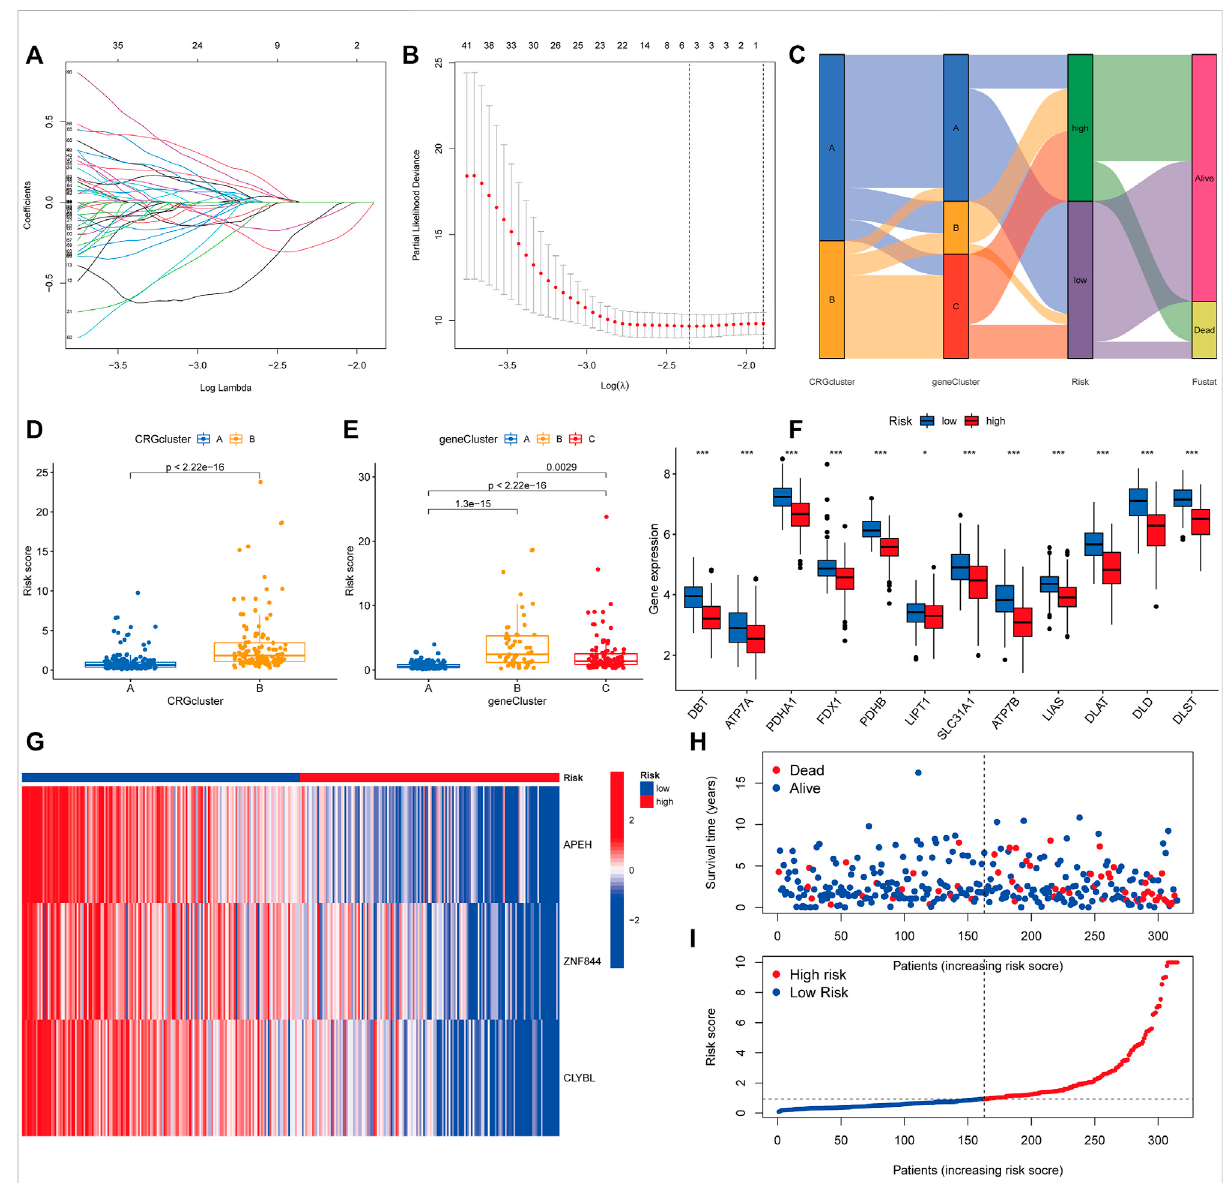
FIGURE 6 Developing the prognostic risk score. (A,B) Least absolute shrinkage and selection operator (LASSO) regression and partial likelihood deviance on prognostic genes. (C) Distributions of various CRG clusters, gene clusters, risk scores, and survival outcomes are shown in alluvial plots. (D) Differences in risk scores between two CRG clusters. The Wilcoxon rank-sum test revealed that the differences between the two clusters were statisticallysigni fi cant( p < 0.001). (E) Differencesinriskscoresamongthreegeneclusters.TheKruskal-Wallistest( p < 0.001)wasusedtoassess the differences between the three gene clusters. (F) Histogram of mRNA expression of CRG between high-risk and low-risk score groups. (G) Heatmap ofthreesigni fi cantgenes acrossdifferentriskscores. (H,I) Distribution ofriskscores and patientsurvivalstatus as shown bydotand scatter